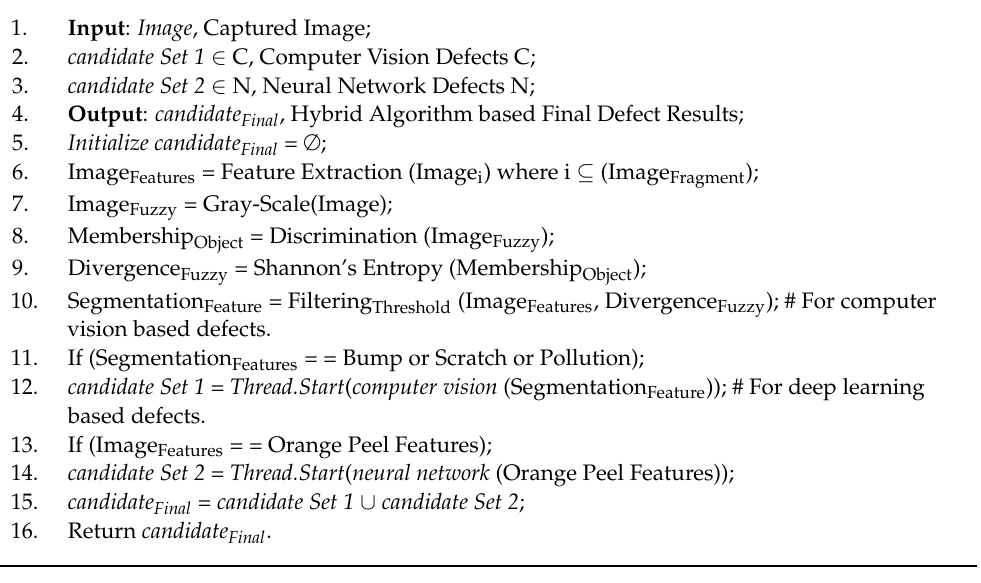
Algorithm 1 AI Landing Algorithm for Drawer Box Defect Detection.